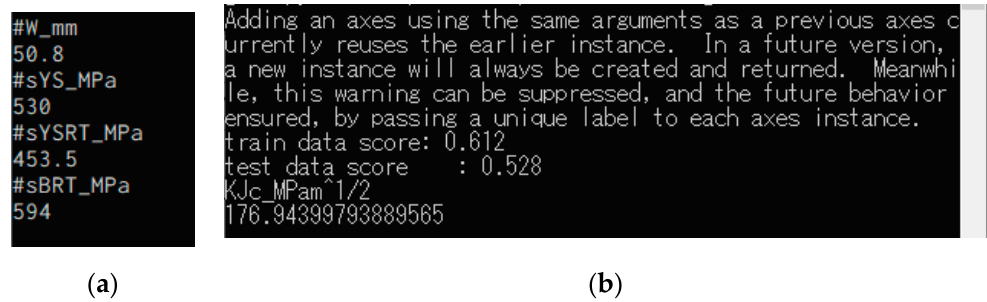
Figure 2. Input data (left figure) and window after execution (right figure). ( a ) Input data; ( b ) Output window.